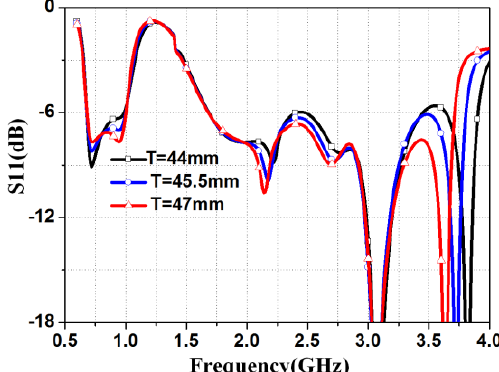
Figure 5. Simulated S-parameters with different values of T.